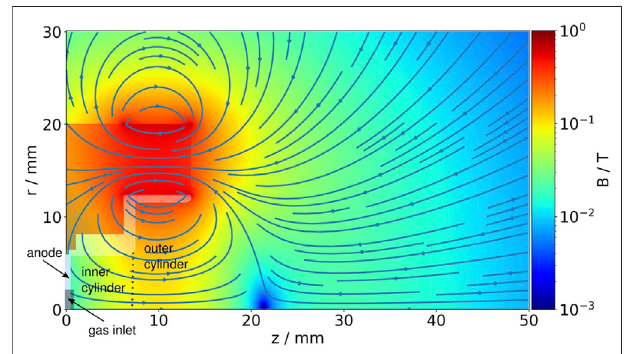
FIGURE 1 | Magnetic fi eld of the MS4 thruster. Field lines are plotted on top of the magnetic fl ux density B. The strength of the magnetic fl ux is color- coded. The metal casing (transparent red) and dielectric (transparent white) are also denoted. Anode and the neutral gas inlet are shown. The two thruster channel regions labelled inner and outer cylinder are also